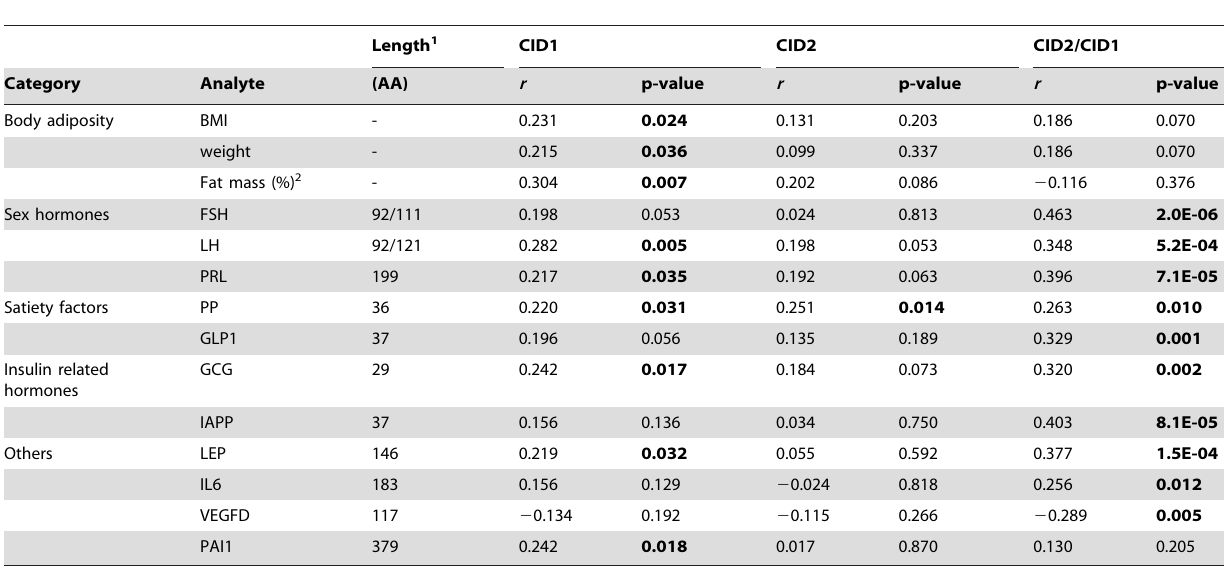
Table 4. Significant correlations between ACE and measures of obesity and other blood